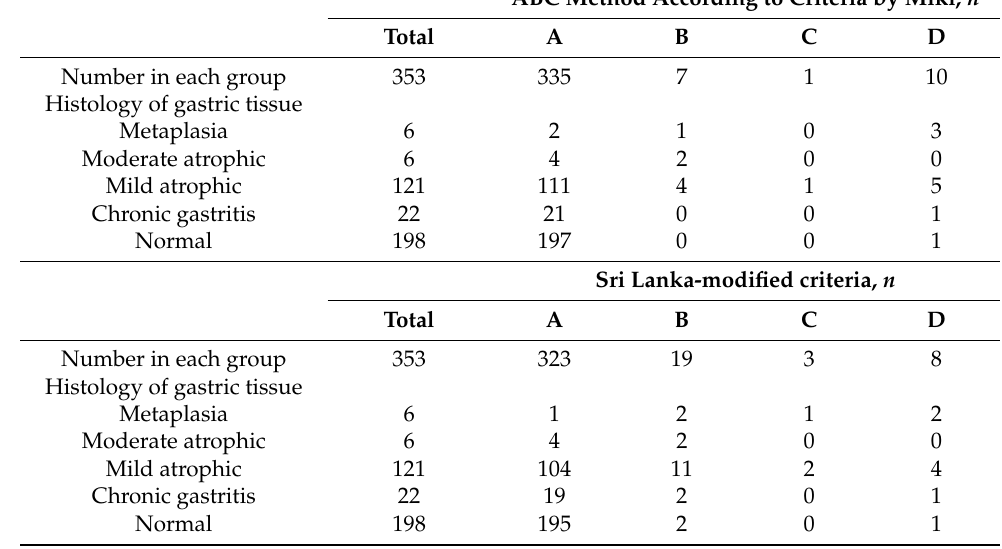
Table 6. Gastric mucosa status of each group using the ABC method with the Miki criteria versus the Sri Lanka-modified